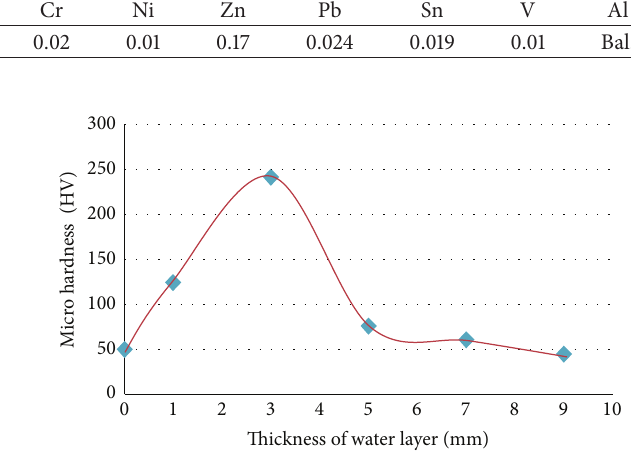
Figure 5: Microhardness [HV] of 2024-T3 aluminum.